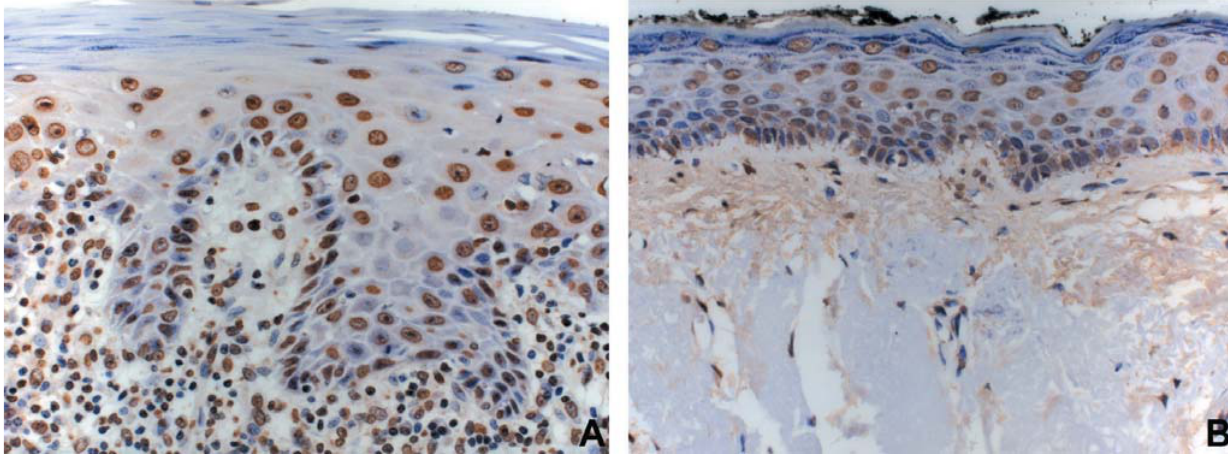
FIGURE 3 - Mild and Moderate epithelial dysplasia in actinic cheilitis. Intense MDM2 nuclear immunostaining in all stratified epithelium cells (A); MDM2 nuclear immunostaining predominantly in suprabasal layer cells (B). Streptavidin-biotin ~